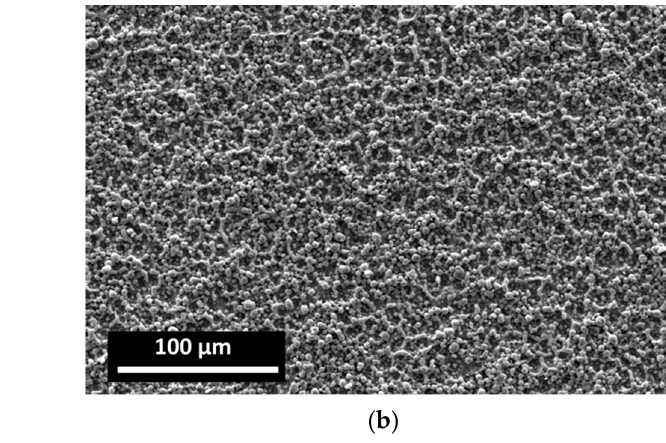
Figure 12. ( a ) Picture of the target Ti onto Al. ( b ) SEM image of the